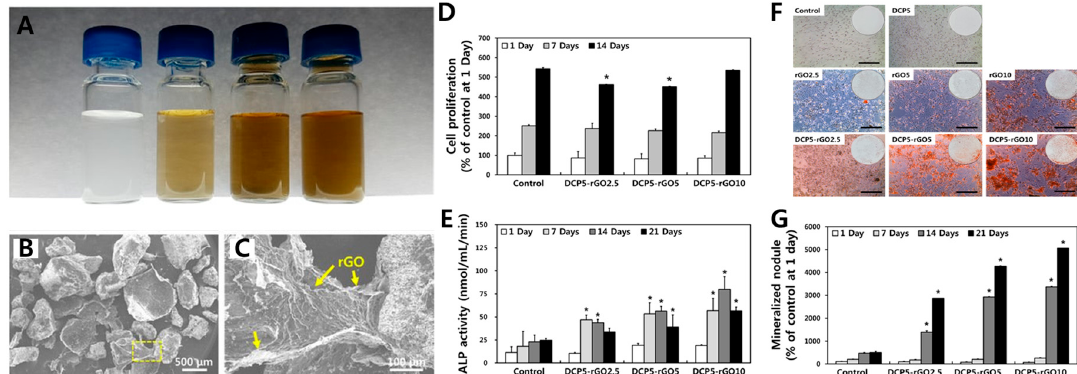
Figure 5. DCP-rGO hybrid composites for osteogenesis of MC3T3-E1 preosteoblasts. DCP and rGO at concentration ratios of 5:2.5, 5:5, and 5:10 μ g/mL were designated as DCP5-rGO2.5, DCP5-rGO5, and DCP5-rGO10, respectively. ( A ) (From the left) Digital images of phosphate-buffered saline (PBS), rGO2.5, DCP5-rGO5, and DCP5-rGO10. ( B ) Low and ( C ) high magnification SEM of DCP-rGO hybrid composites. ( D ) Proliferation, ( E ) ALP activity, ( F ) macroscopic images of ARS staining, and ( G ) mineralization nodules of MC3T3-E1 cells cultured with DCP-rGO composites. An asterisk (*) denotes significant difference compared to the control of the same day. Data reproduced from Ref. [86]. Copyrights MDPI 2017.